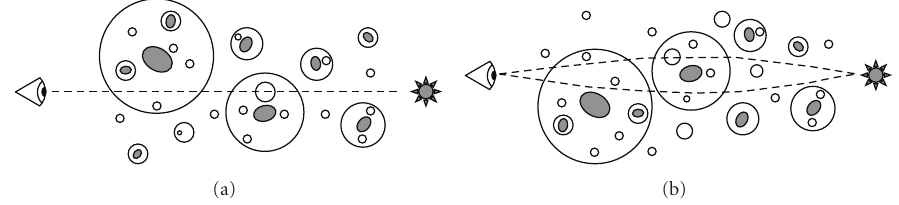
Figure 2: Macrolensed and singly imaged sources. (a) The sightline towards a distant light source passes through many dark matter halos with subhalos, but too far from the dense galaxies in the centres of halos for macrolensing to occur. A subhalo in one of these halos happens to intersect the line of sight, thereby potentially producing millilensing e ff ects in a singly imaged light source. (b) One of the halos happens to lie almost exactly on the line of sight, thereby splitting the background light source into separate macroimages. Furthermore, one of the subhalos in the main lens lies on the sightline towards one of the macroimages, thereby producing millilensing e ff ects in this macroimage.